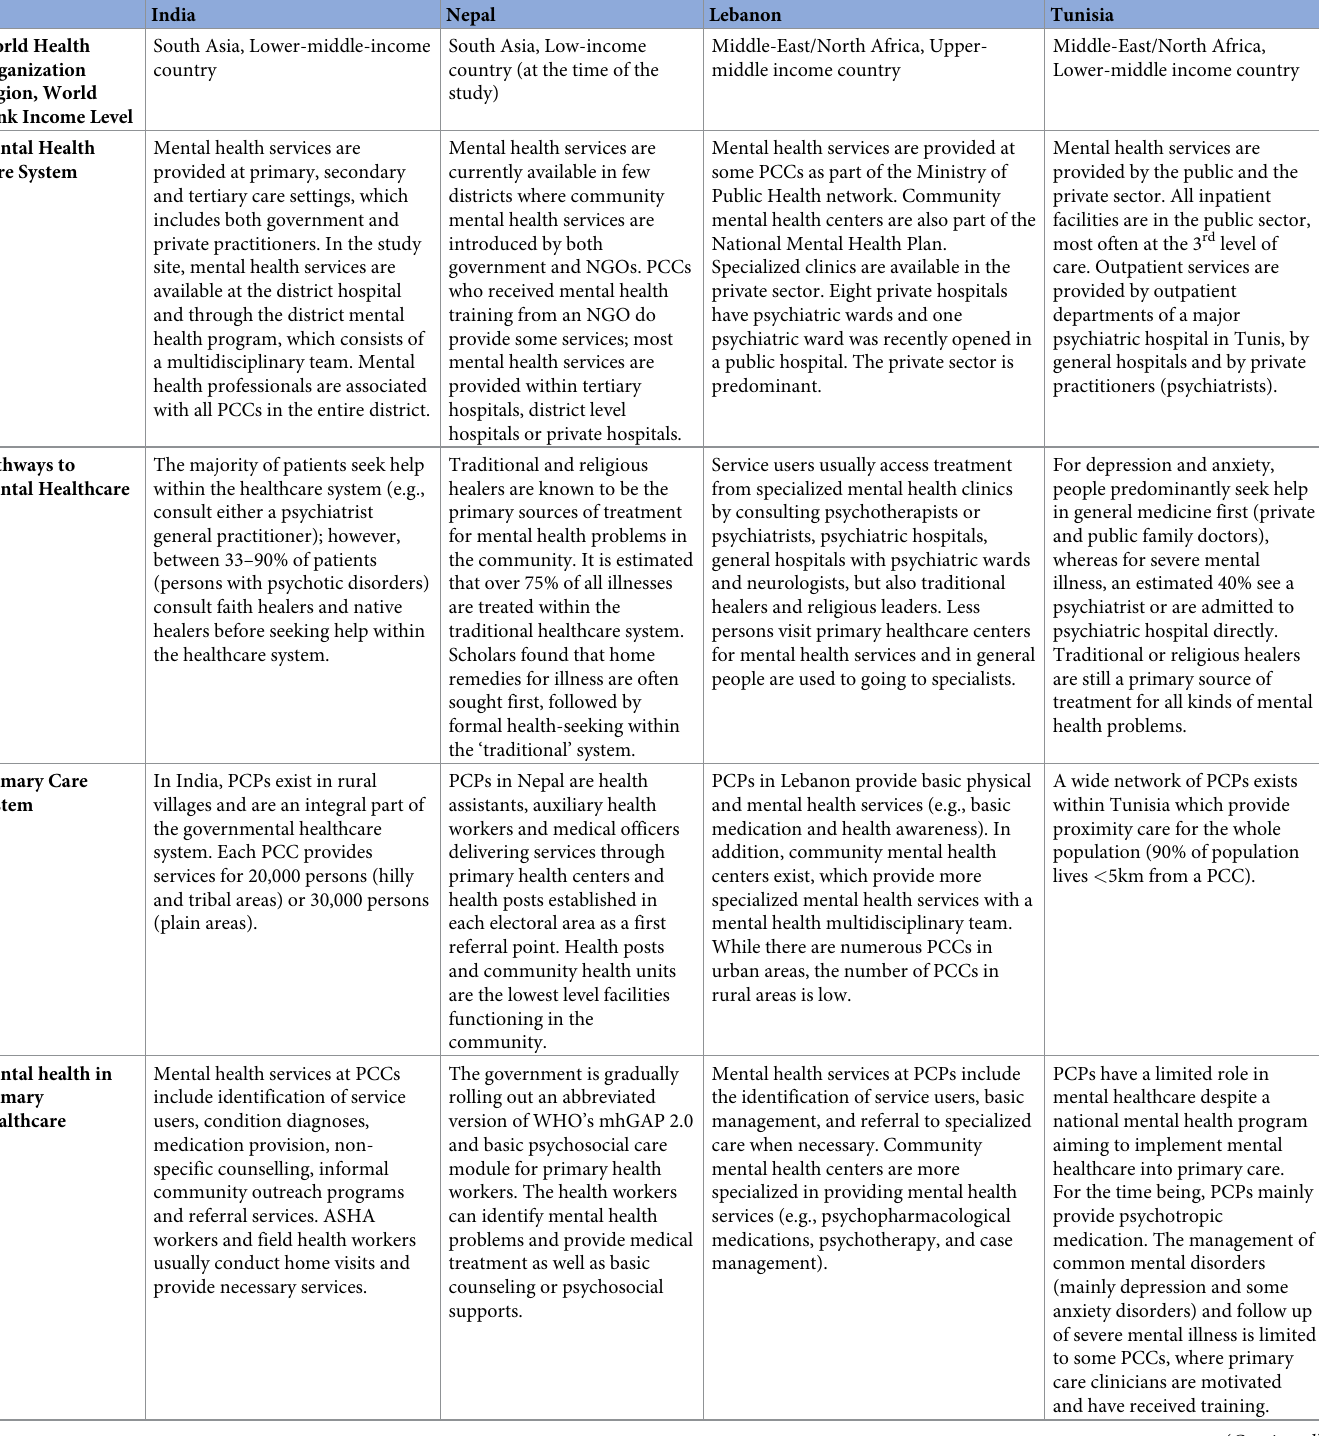
Table 1. Overview of mental health and primary care in participating countries: Low- and middle-income countries